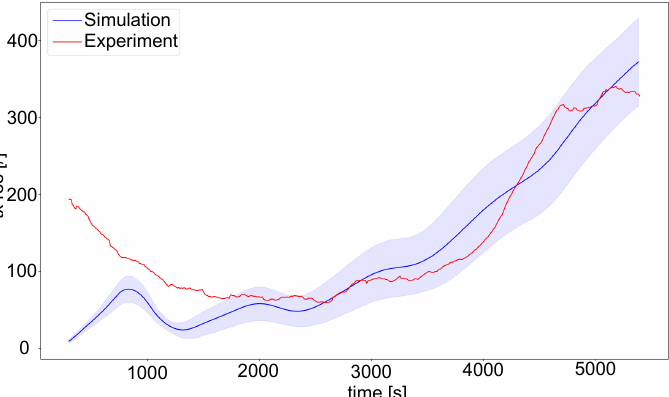
Figure 12. Comparison of transaction fee between experimental and simulation results.